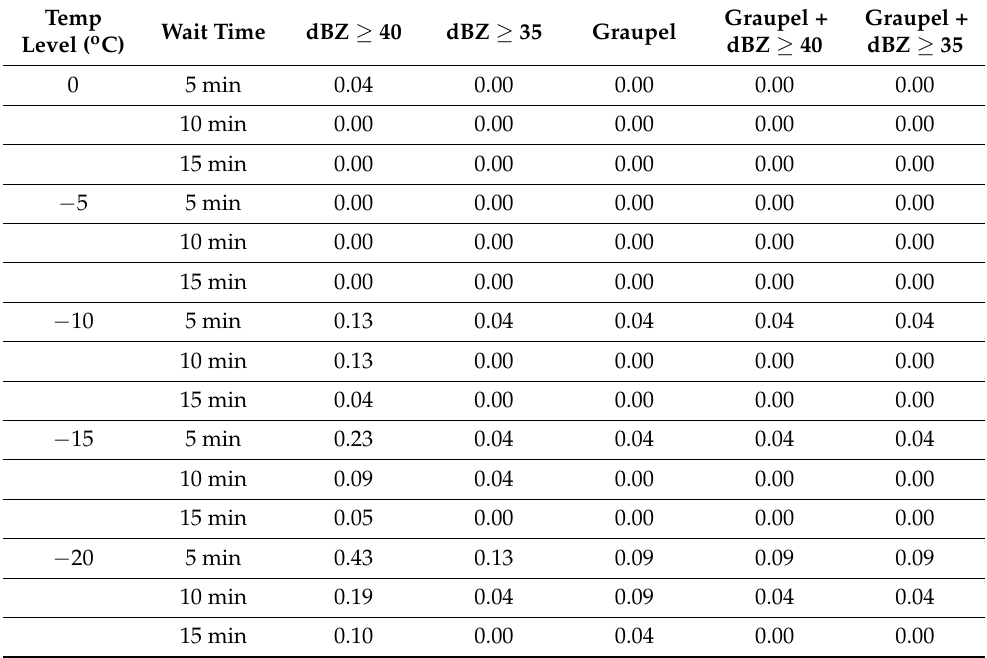
Table 3. False Alarm Ratio is defined by the total number of false alarms divided by the total number of hits and false alarms: FAR = total false alarms/(total hits + total false alarms).